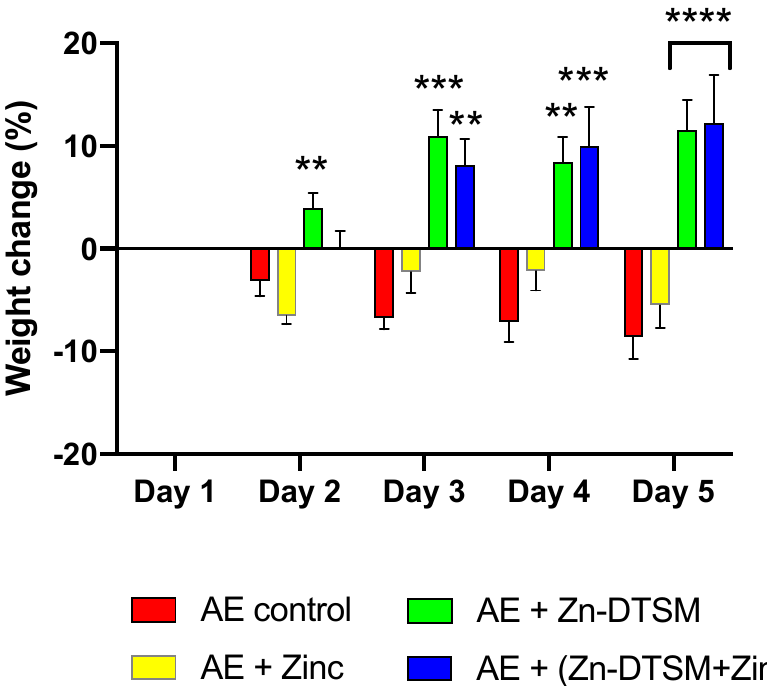
Figure 3. Weight change data (%) for young (1.5-month) acrodermatitis enteropathica (AE) animals treated with Zn-DTSM (30 mg/kg/day). There was an overall significant effect of treatment group (RM ANOVA, p < 0.0001) and also a significant interaction effect ( p < 0.0001) across the study. The AE control animals show the expected weight loss across the five days of the experiment, which is marginally offset with dietary zinc supplementation. In contrast, the administration of either Zn-DTSM alone, or in combination with dietary zinc supplementation, results in a profound shift in the phenotype such that the animals gain significant amounts of weight over the time course. Data are mean ± SEM. ** p < 0.01, *** p < 0.001, **** p < 0.0001 (all compared to AE+Zinc; on Day 5, both columns are significantly different to the AE+ Zinc group).